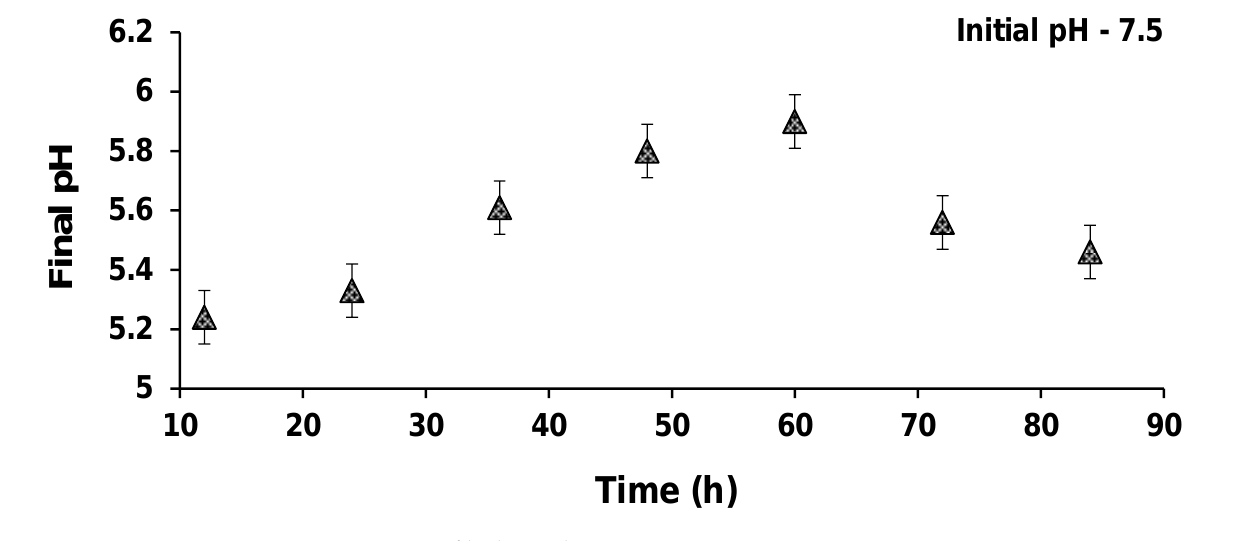
Figure 7. pH profile during kinetics.